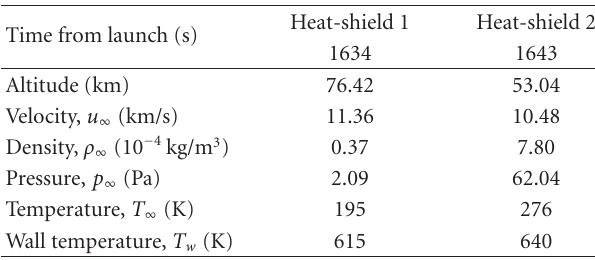
Table 3: Flow conditions for the Fire II reentry